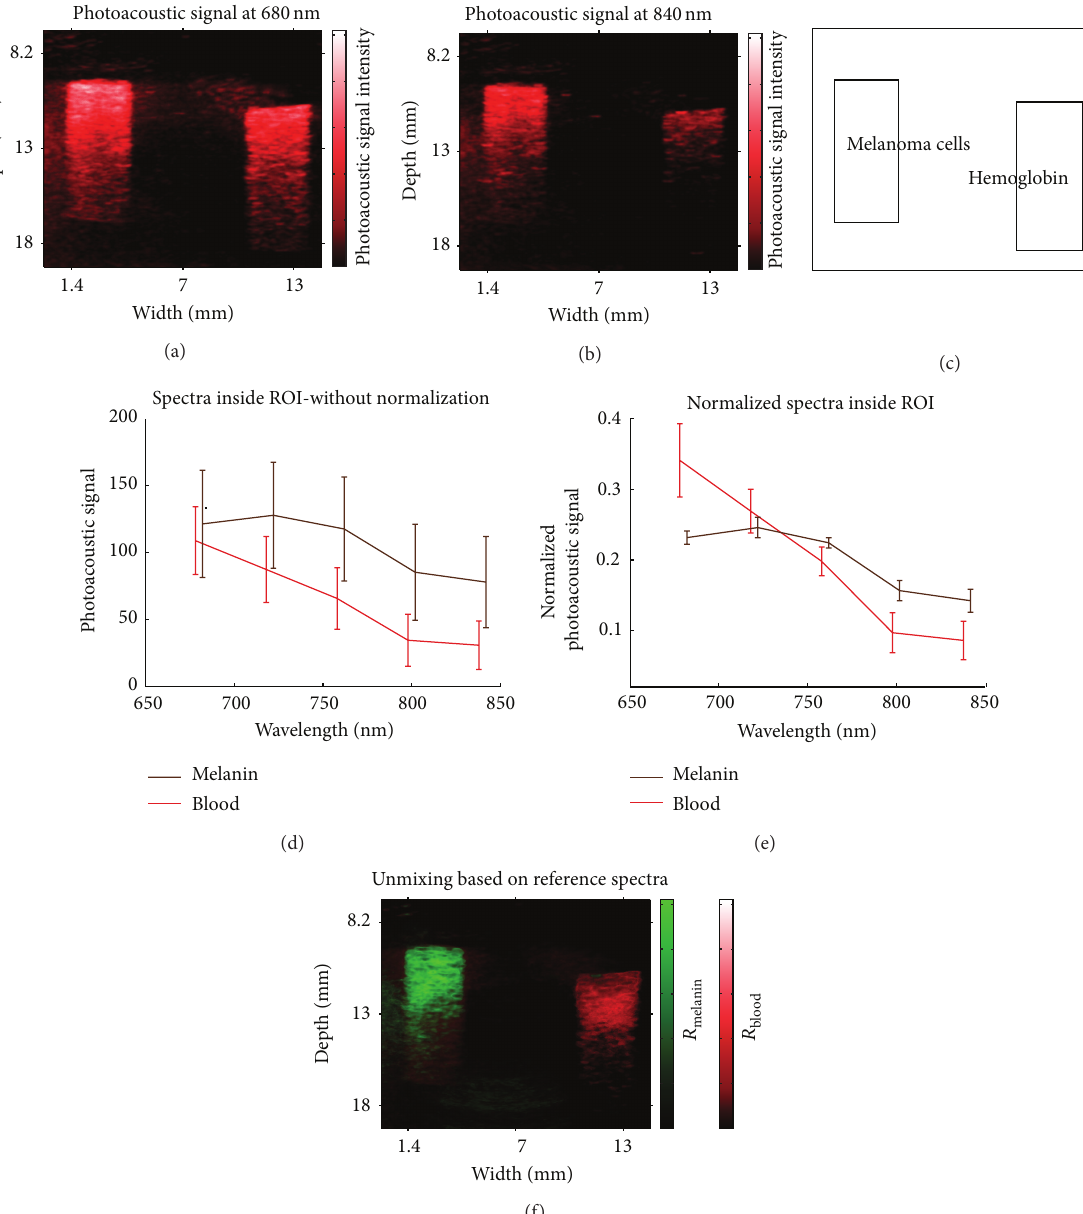
Figure 1: (a) Photoacoustic image of phantom after illumination with 680 nm light. (b) Photoacoustic image of phantom after illumination with 840 nm light. (c) Relative position of the inclusions in (a), (b), and (f). (d) Measured spectra for the two regions indicated in (c) for five wavelengths before normalization. The curves represent average and error bars indicate standard deviation. (e) Reference spectra after per-pixel normalization. The curves represent average and the error bars indicate standard deviation. (f) Resemblance score for blood ( 𝑅 ) expressed as pseudocolors, hemoglobin in red and melanin in and melanin ( 𝑅 melanin